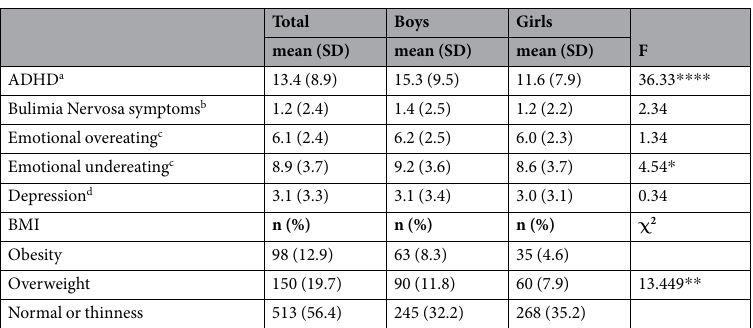
Table 2. The partial correlation among variables controlling for gender. a ADHD Rating Scale-IV; b Children’s Eating Attitude Test; c Child Eating Behaviour Questionnaire; d Child Behavior Checklist. * P < 0.05, ** P < 0.01, **** P <